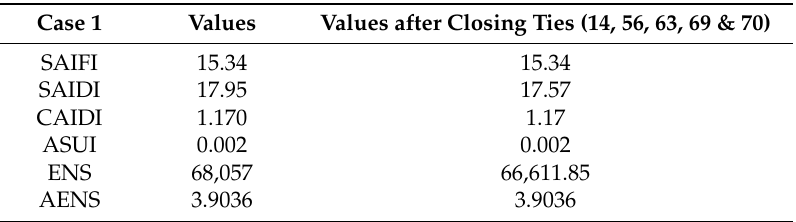
Table 3. System indices as based in Case 1.